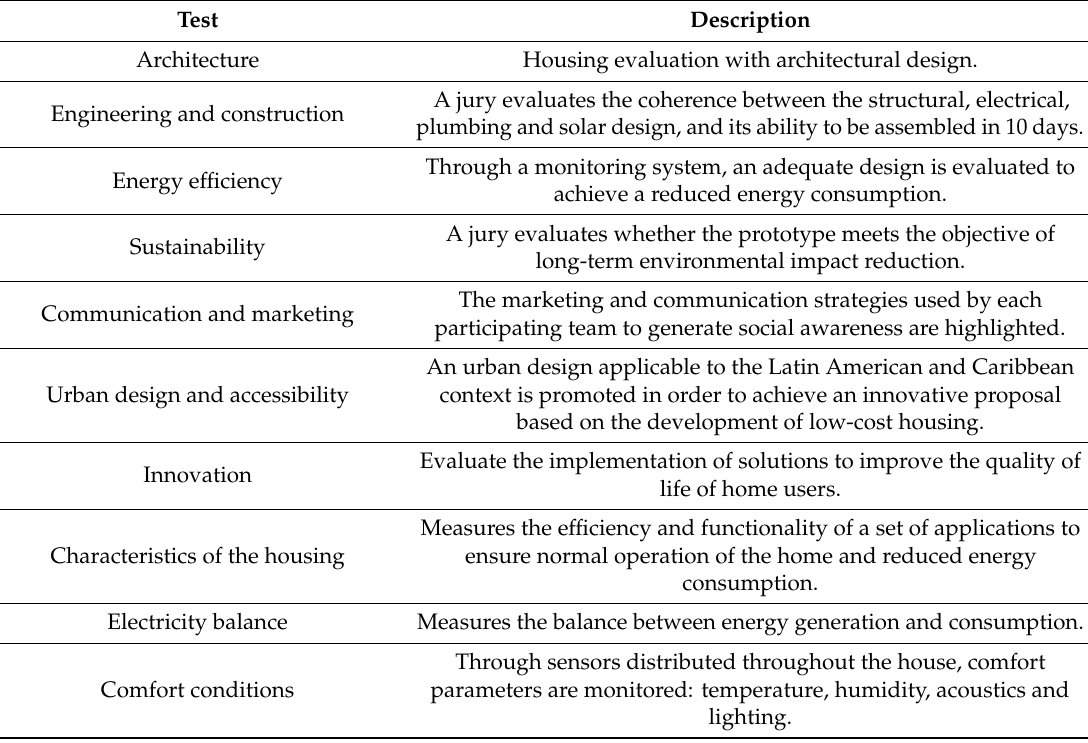
Table 1. Analysis of the 10 contests of the